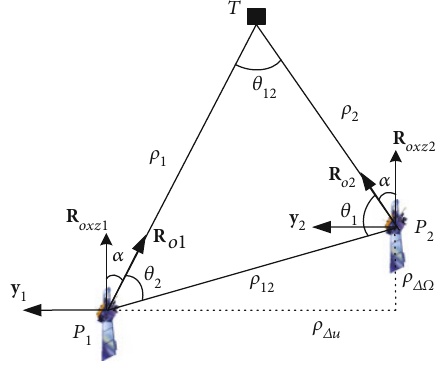
Figure 9: The geometry of dual-point of view